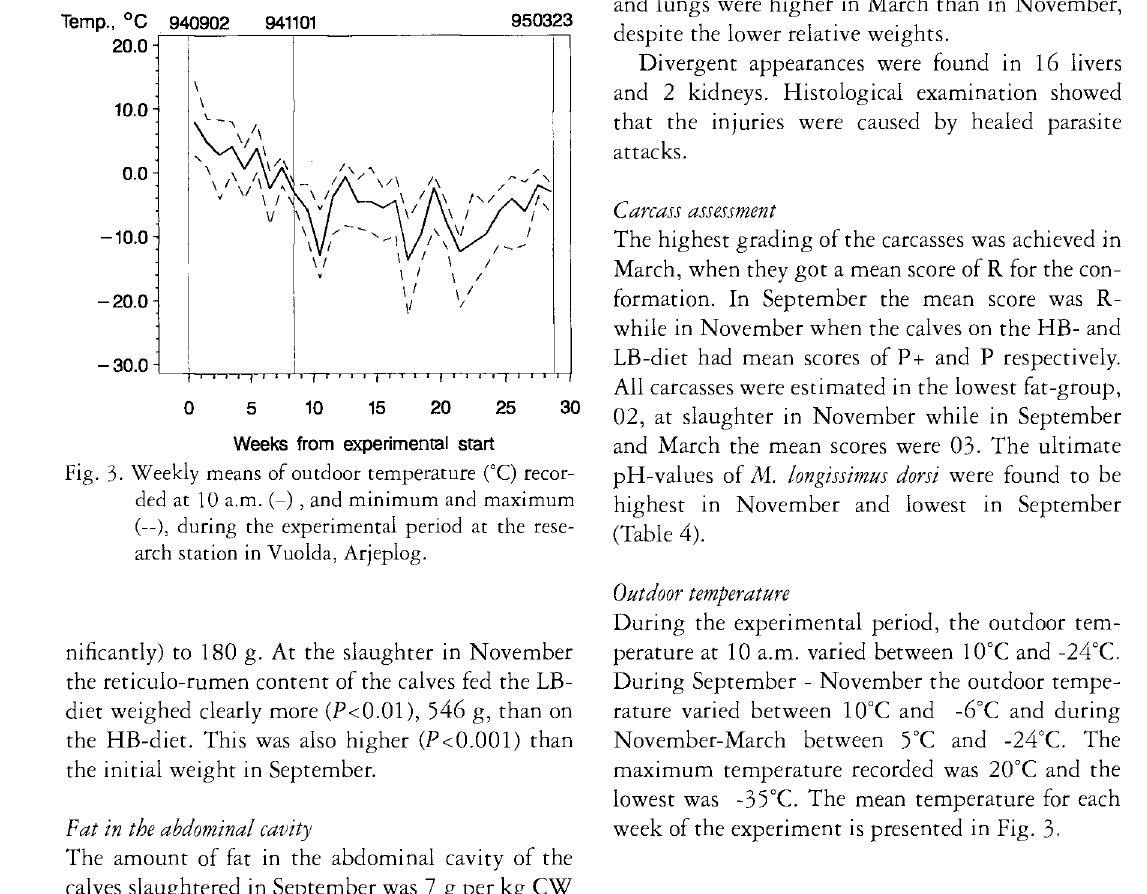
Fig. 3. Weekly means of outdoor temperature (°C) recor ded at 10 a.m. (-) , and minimum and maximum (—), during the experimental period at the rese arch station in Vuolda,